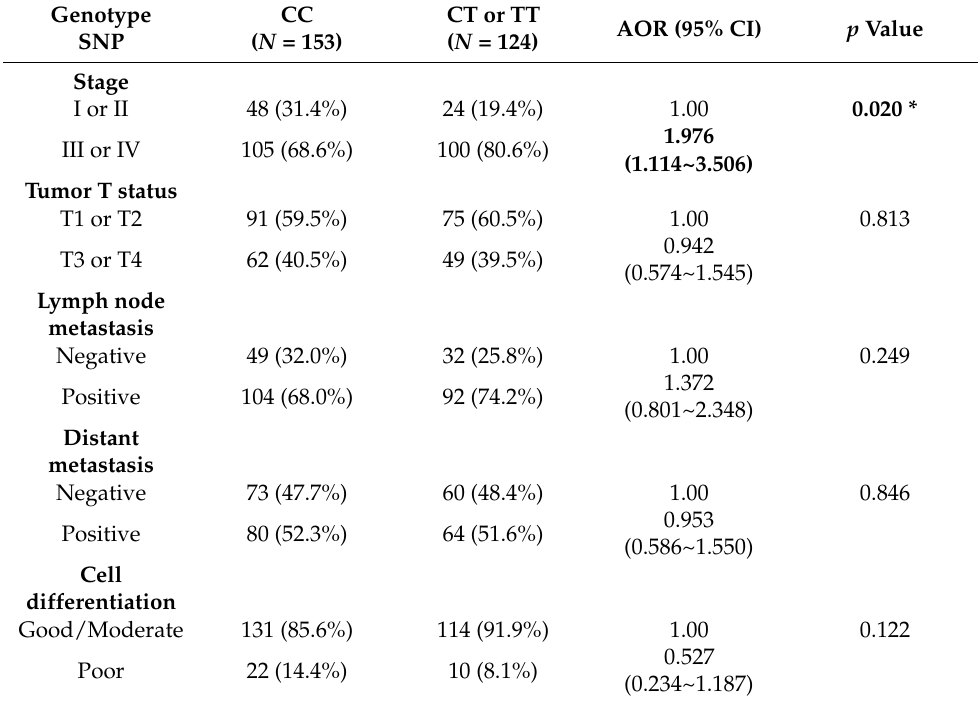
Table 3. Clinicopathologic characteristics of lung adenocarcinoma patients stratified by polymorphic genotypes of interleukin ( IL )- 17A